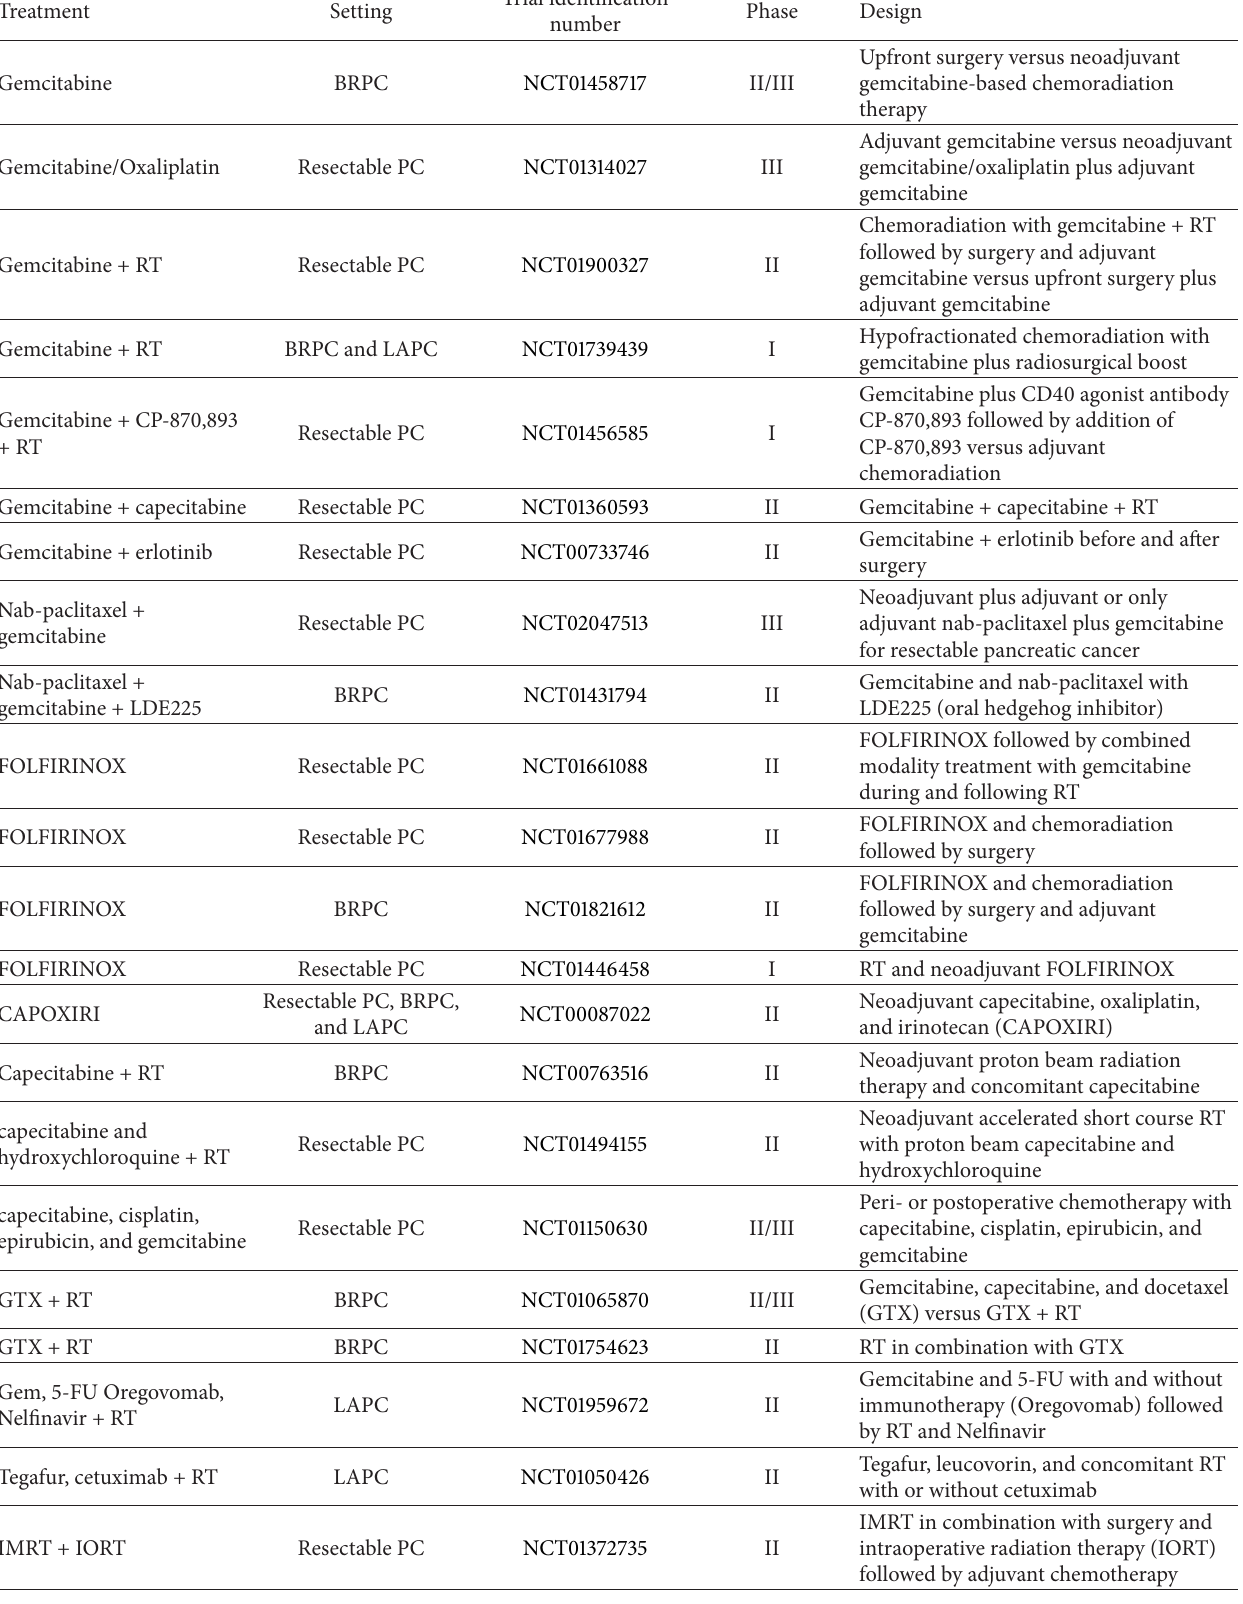
Table 3: Ongoing clinical trials in neoadjuvant setting in